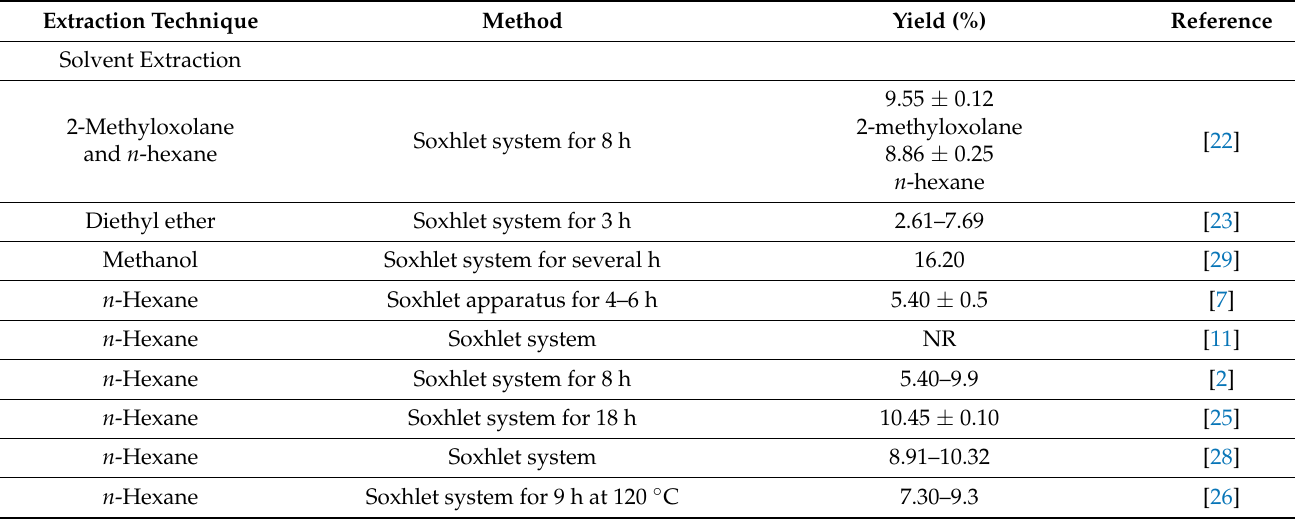
Table 1. Different extraction methods, solvent, extraction time and yield of prickly pear seed